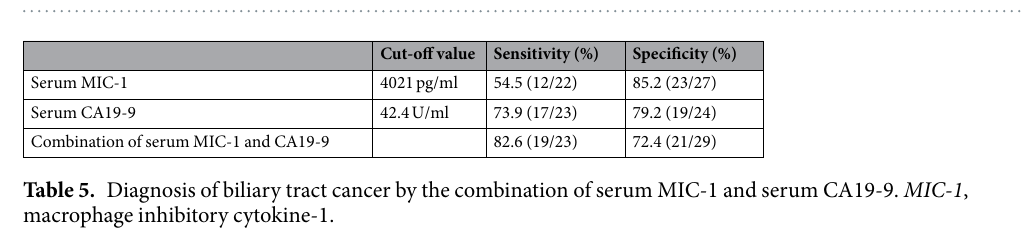
Table 4. Comparison of early malignant diagnosability between biliary MIC-1 and biliary cytology. MIC-1 , macrophage inhibitory cytokine-1.